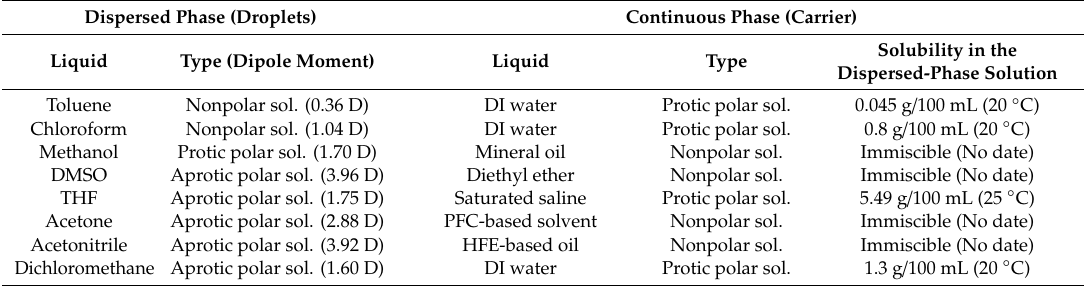
Table 3. Combinations of continuous-phase and dispersed-phase solutions used in this